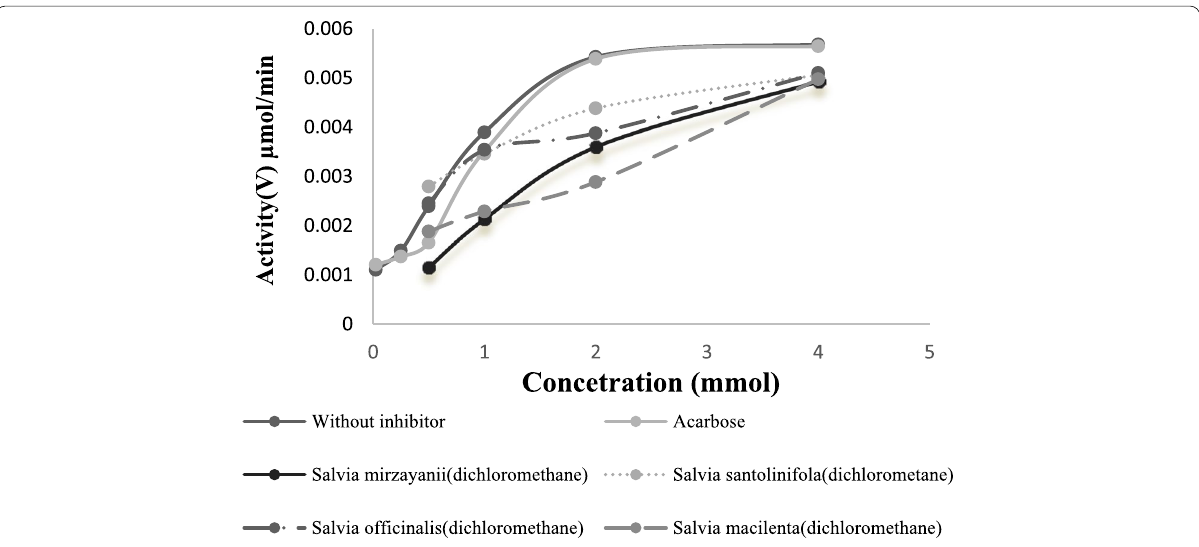
Fig. 3 Michaelis Menten curves of dichloromethane extracts of Salvia species in comparison to reaction without inhibitor and acarbose as a